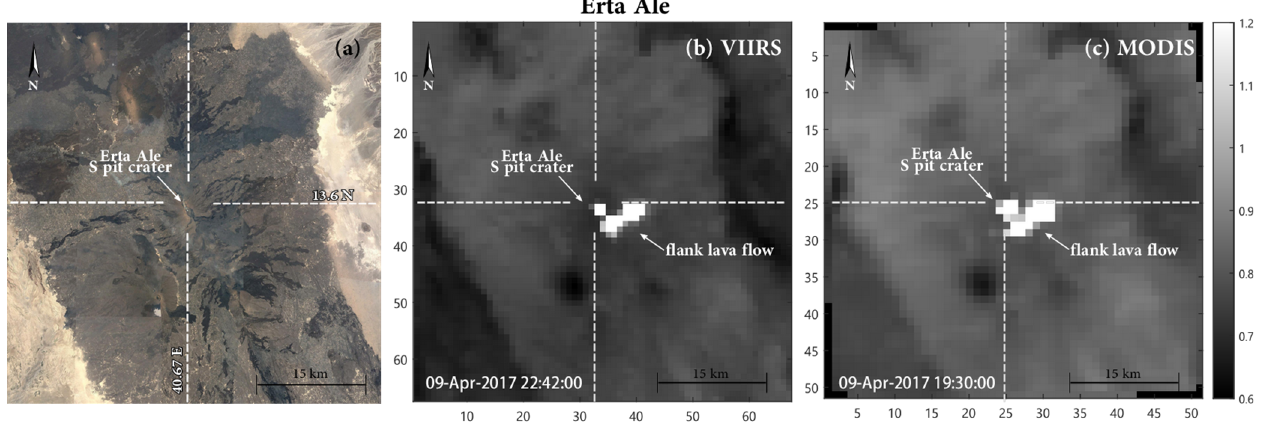
Figure 3. ( a ) Location of Erta Ale volcano (credits: Google Earth ® ); ( b , c ) examples of VIIRS ( b ) and MODIS ( c ) images acquired over Erta Ale. The images represent MIR radiance data (band M13 and band 21/22, for VIIRS and MODIS, respectively) resampled and centered on the volcano summit at the original resolution of 750 m (for VIIRS) and 1000 m (for MODIS).